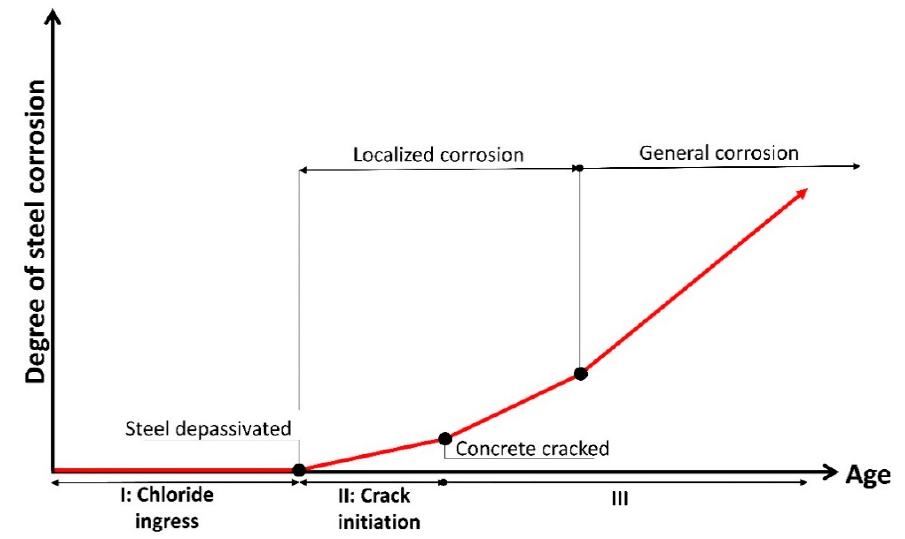
Figure 2. Schematic of three-phase deterioration of RC structures.